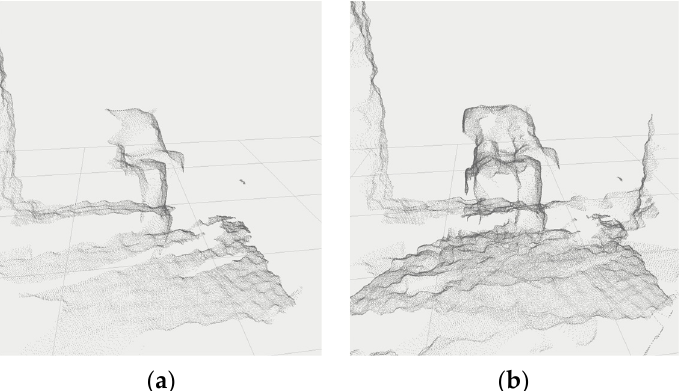
Figure 4. Merged point clouds (data from camera Intel Realsense D435i with 1280 × 720 resolution) in the workplace coordinate system: ( a ) data from camera D; ( b ) data from cameras A and D (cameras transformation was calibrated by [32]).